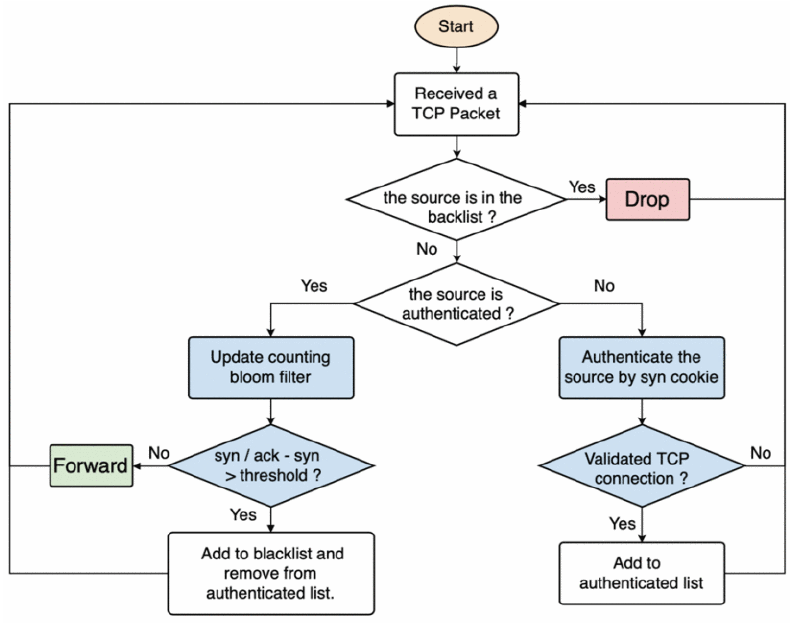
Figure 3. Two-step P4-based SYN and UDP flooding mitigation and identification